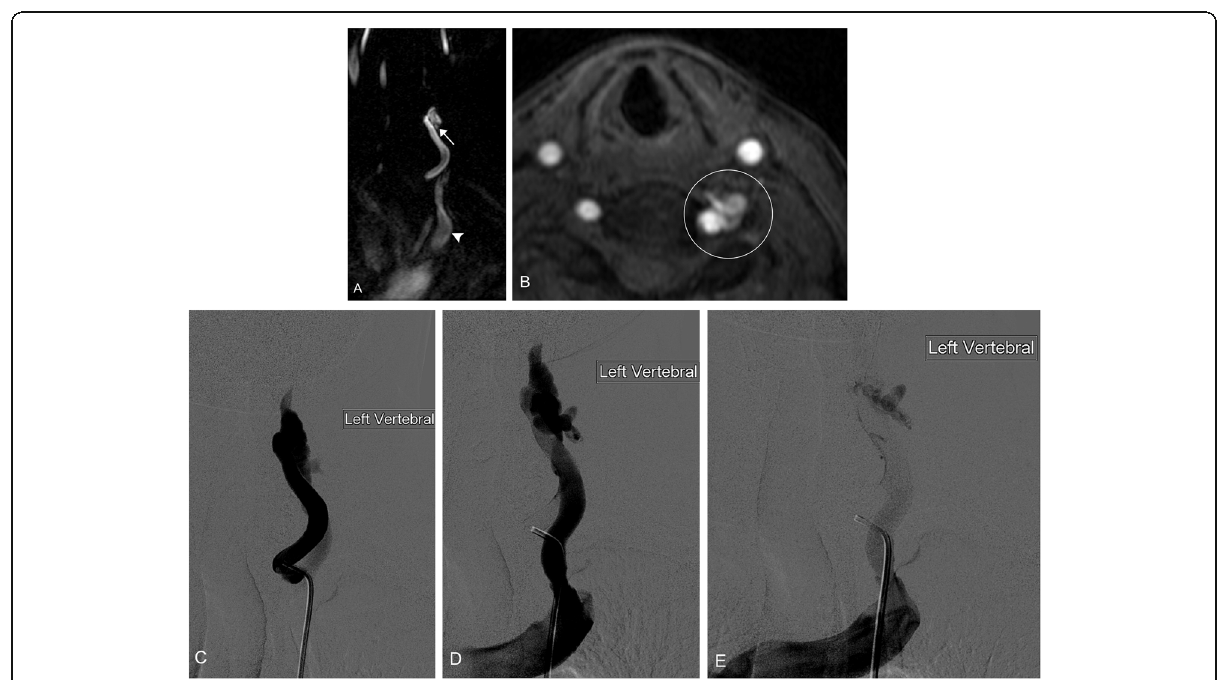
Fig. 12 Arteriovenous fistula. A 57-year-old female presents with history of left neck bruit. a Post-contrast MRA images of the neck demonstrate a tortuous course of the left vertebral artery extending into fistulous enlargement at the C6 level (arrow) where there is early filling into the draining vein (arrowhead). b Axial post-contrast MRA image demonstrates fistulous enlargement of the vertebral artery (circle). c Conventional angiography with selective injection of the left vertebral artery shows enlargement at the proximal portion. d, e Progressive angiographic